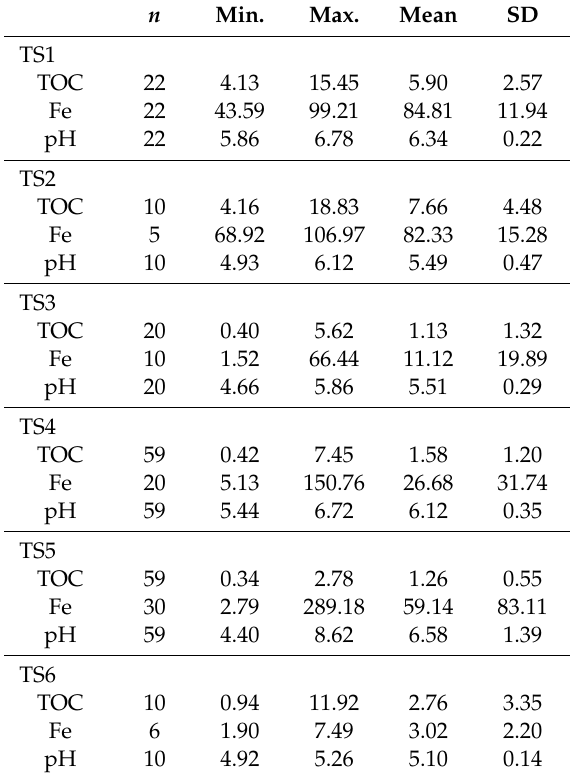
Table 4. Statistics of the data for the TOC a (g / kg), Fe (mg / kg), and pH (in unit). n Min.